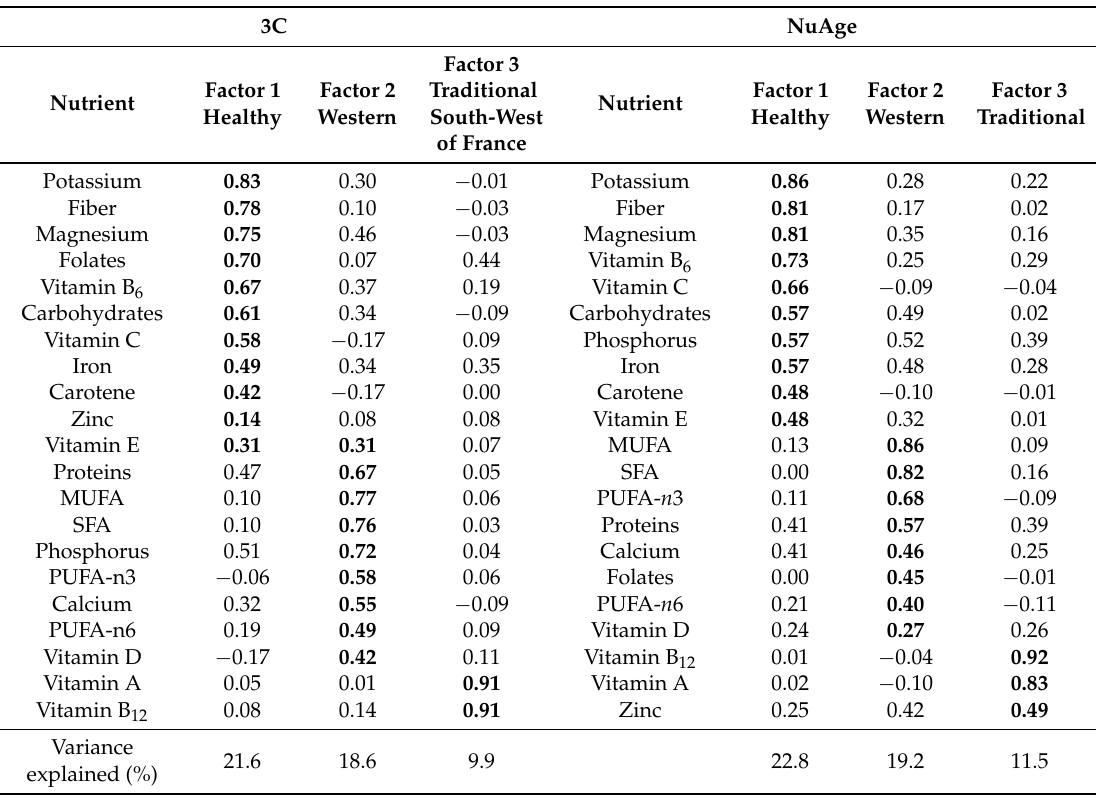
Table 2. Nutrient patterns obtained by factor analysis using principal component analysis of nutrient